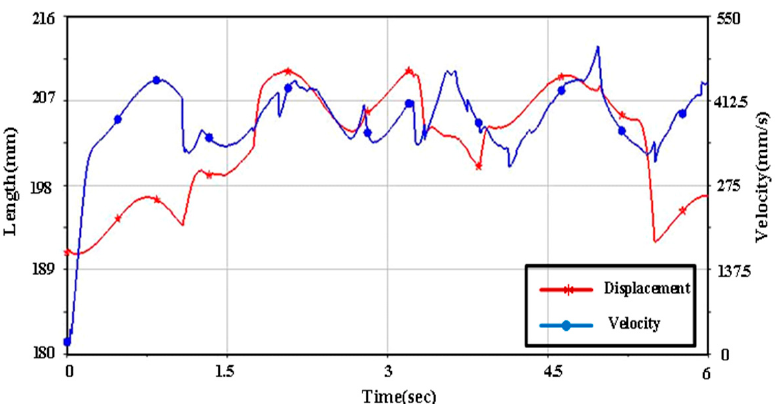
Figure 21. Simulation results of robot unilateral step displacement and velocity variation.